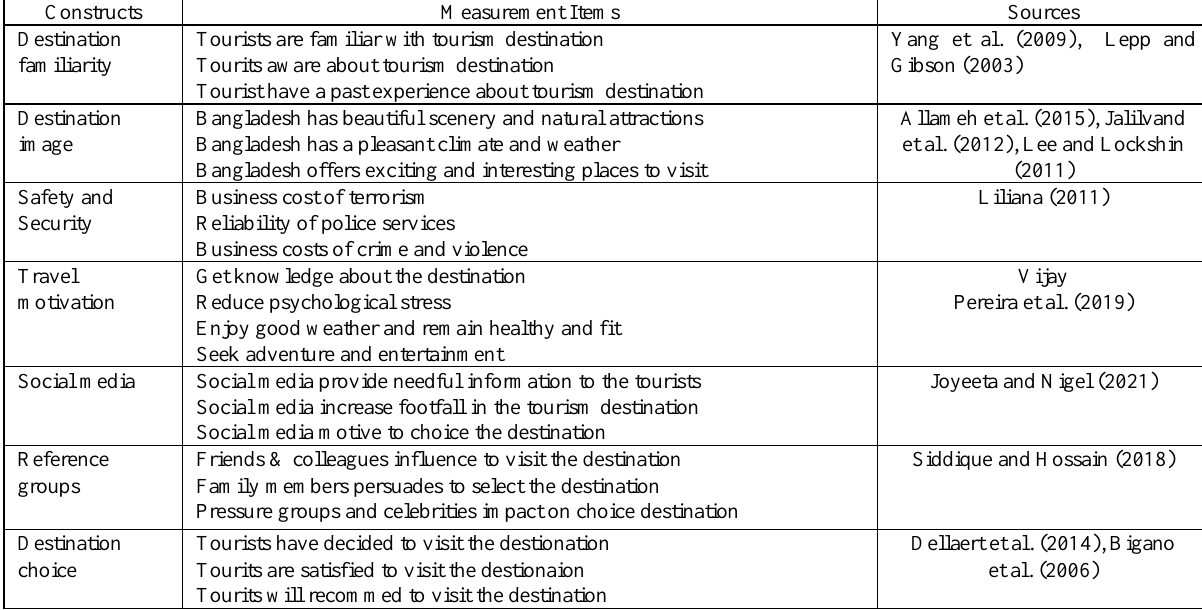
Table 1. Constructs and measured